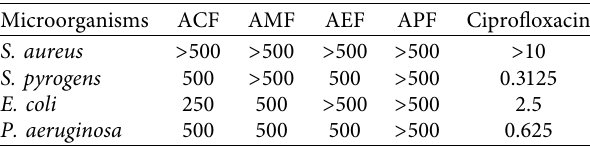
Table 3: Minimum inhibitory concentrations of A. macrostachya extract and